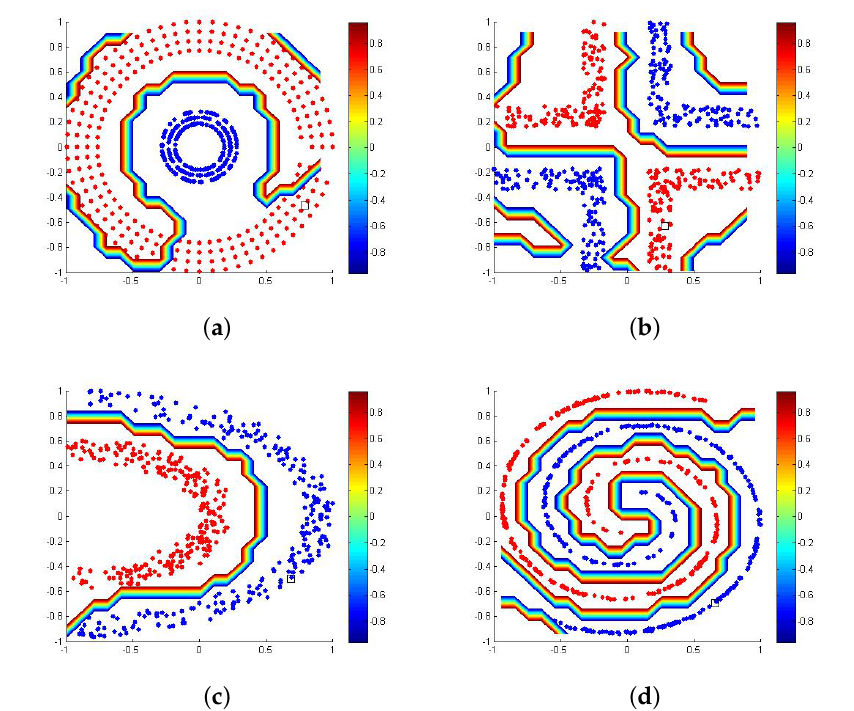
Figure 5. ( a ) Data set Cluster Classification. ( b ) Data set Corners Classification. ( c ) Data set Half Kernel Classification. ( d ) Data set Spiral